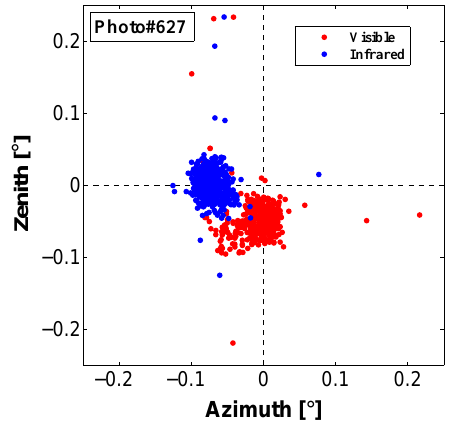
Fig. 11. Zenith and azimuth pointing error derived from cross mea- surements for sun-photometer #627 during 2012.